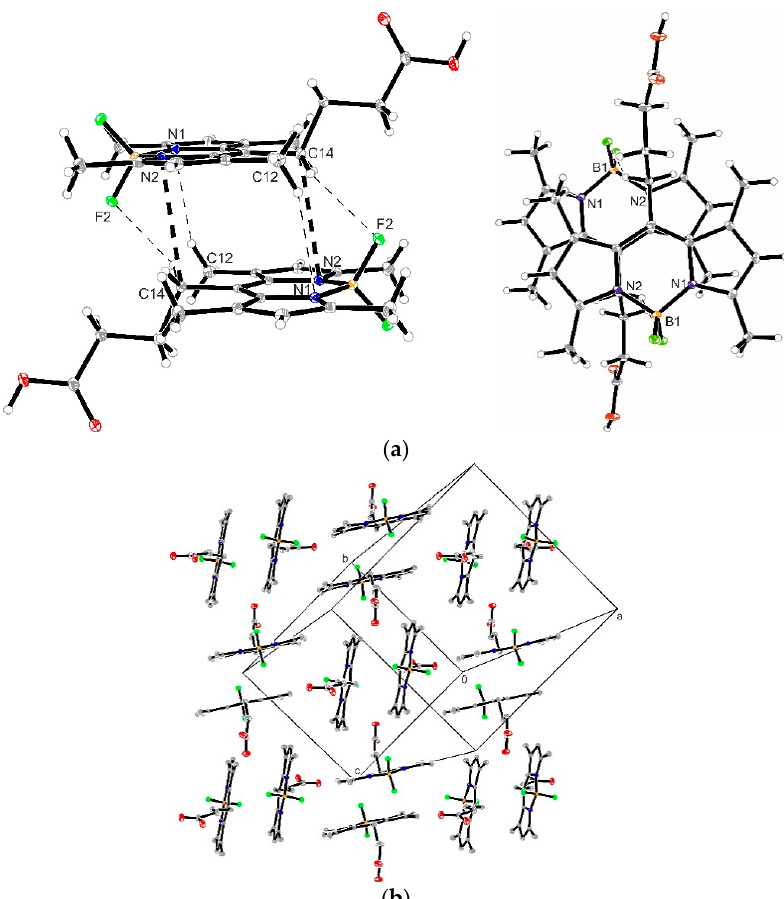
Figure 6. ( a ) View representing the interactions ( π · · · π , C–H · · · N and C–H · · · F) between two BODIPY units in compound 1 ; ( b ) 2D network showing the packing of BODIPY dimeric units.